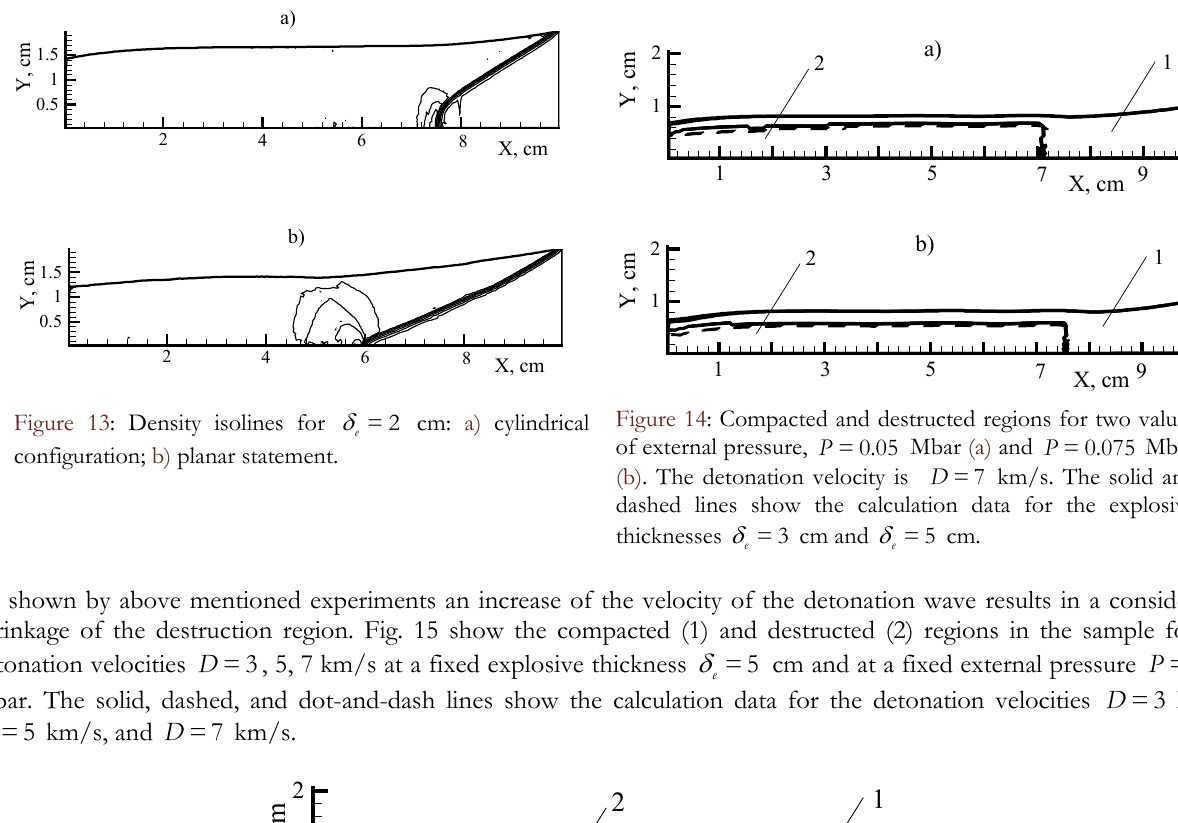
Mbar. The solid, dashed, and dot-and-dash lines show the calculation data for the detonation velocities km/s, and